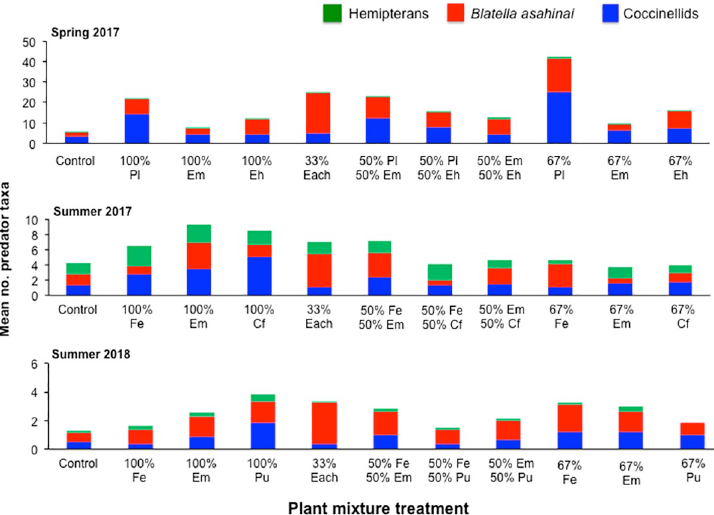
Fig 3. Mean number of natural enemies from different taxa occurring in each conservation plant mixture group during each experiment. Key to plant species abbreviations: Spring 2017: Pl = Phaseolus lunatus , Em = Euphorbia milii , Eh = E . heterophylla ; Summer 2017: Fe = Fagopyrum esculentum , Cf = Chamaecrista fasciculata , Em = E . milii ; Summer 2018: Pu = Portulaca umbraticola , Fe = Fagopyrum esculentum , Em = E . milii .